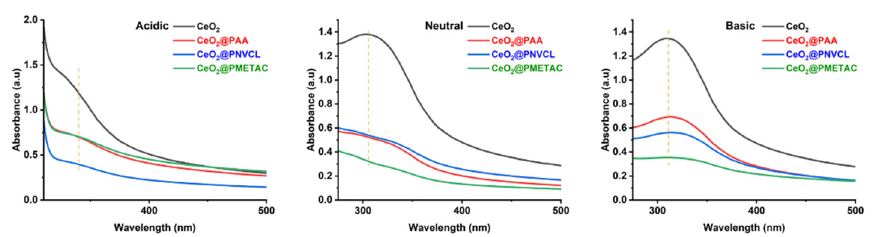
Figure 5. UV results of the CeO 2 and CeO 2 @polymers for three different pH synthesis conditions: acidic, neutral, and basic.